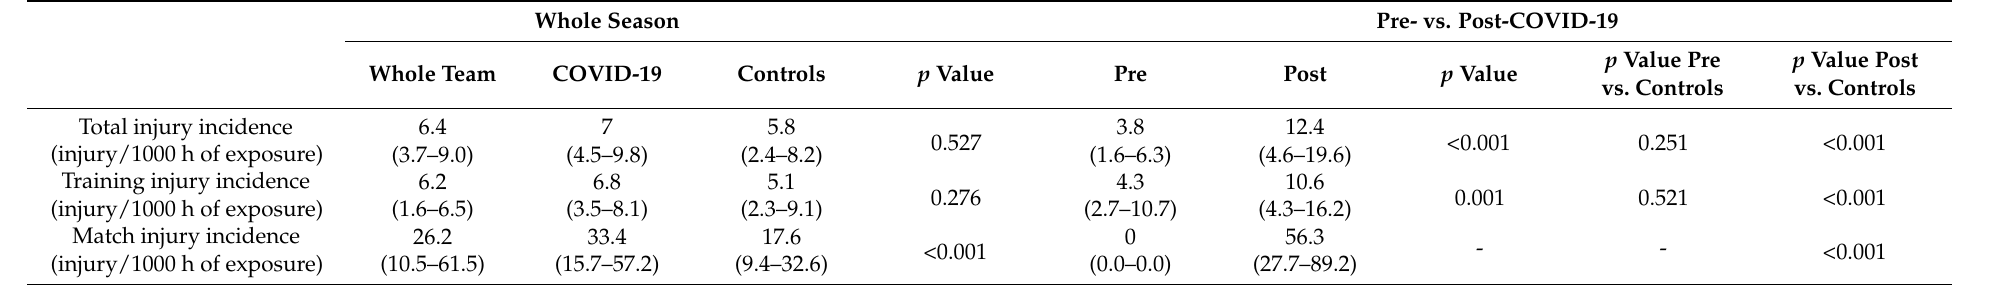
Table 3. Injury incidence during training and competition in players diagnosed with COVID-19 and players who did not have COVID-19 during the 2020–2021 season.